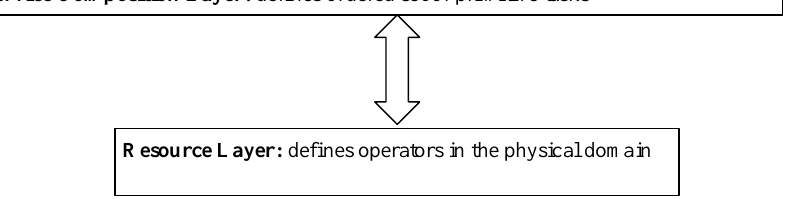
Figure 1. Layered view of the service composition process from a workflow